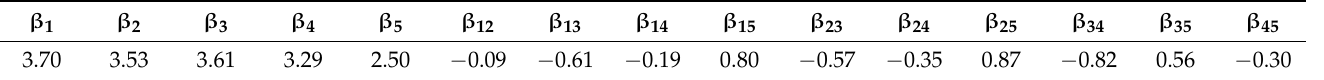
Table 8. Flexural strength model